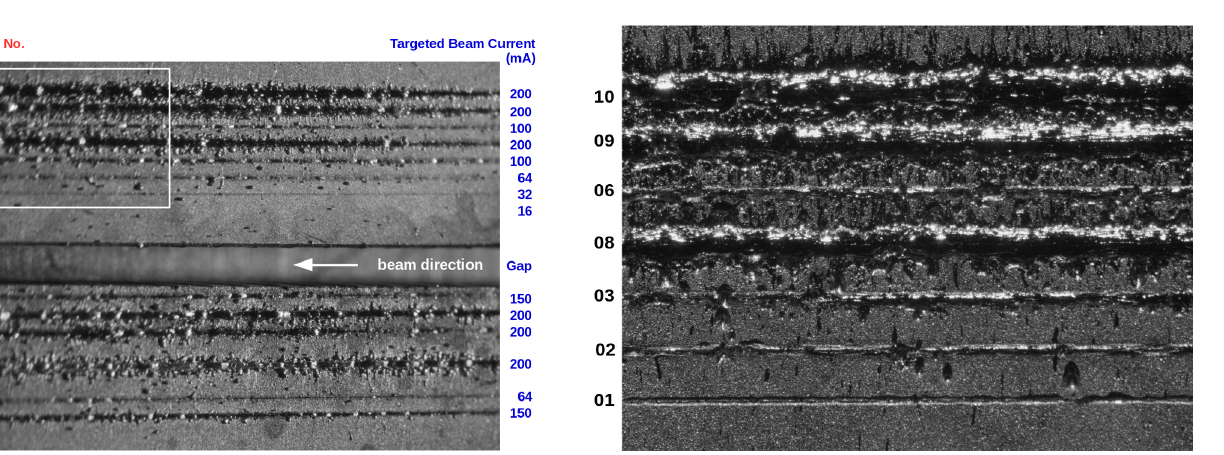
FIG. 23. An enlargement of the boxed region shown in Fig. 22. Sequence numbers, shown on the left, correspond to those given in Table VI; thus, starting from the first visible mark at the bottom are strikes of 34.6, 69.4, 99.1, 202.0, 100.0, 201.2, and 202.1 mA corresponding to sequence numbers 01, 02, 03, 08, 06, 09, and 10, respectively. The vertical separation between each strike position is 0.4 mm. Illumination is from the bottom of the